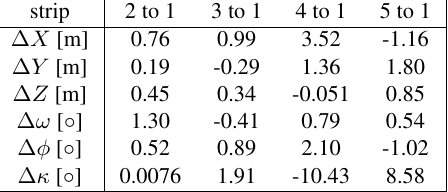
Table 2: Transformation parameter of strips 2 to 5 related to the first strip, all in the north-east-down coordinate system. The